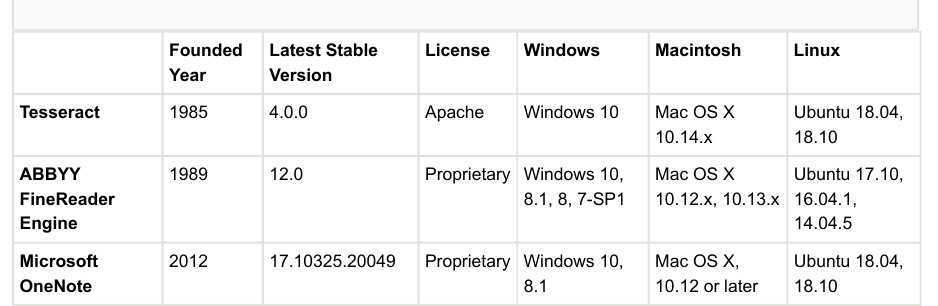
Table 3. Comparison of selected OCR software tools.